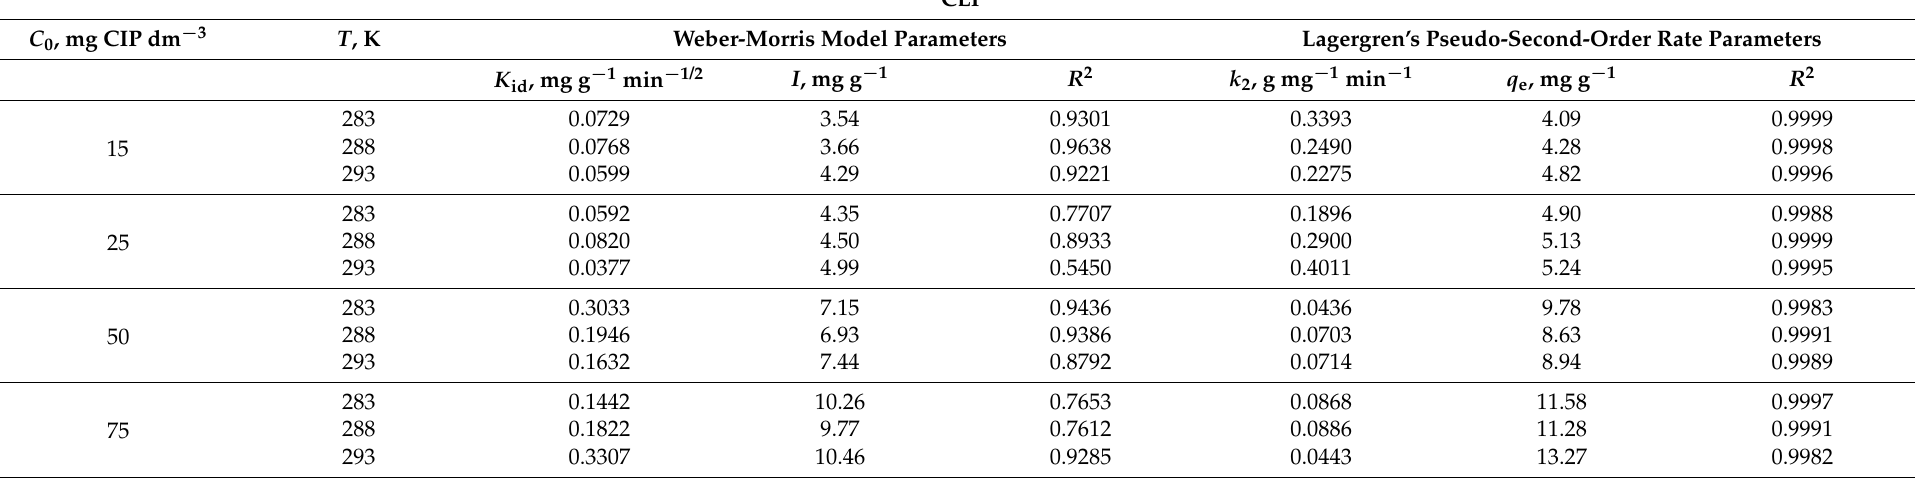
Table 6. Rate constant for the two studied kinetic models for the adsorption of CIP on CLI and MAG-CLI ( R 2 is the correlation coefficient of the linear regression).